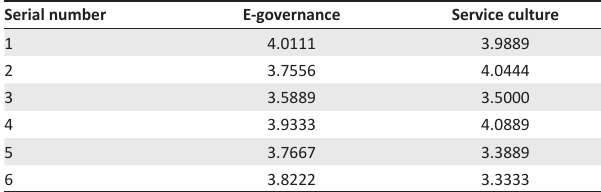
TABLE 3: Available data generated from weighted